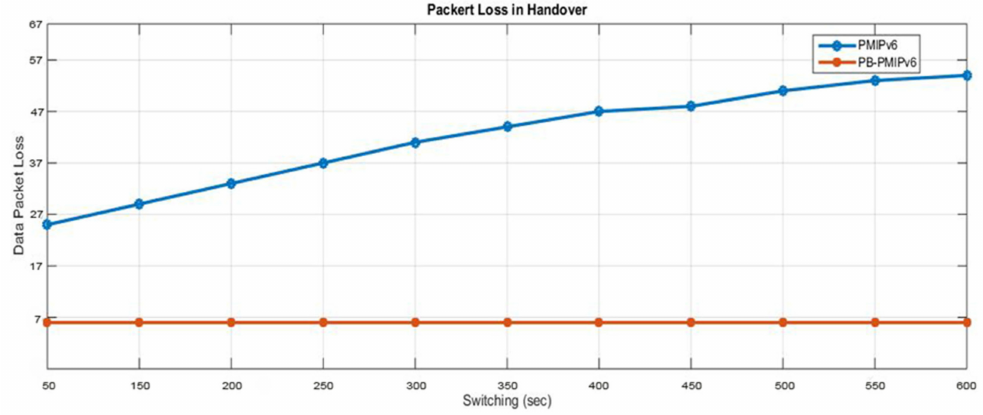
Figure 10. Comparison of lost packets during